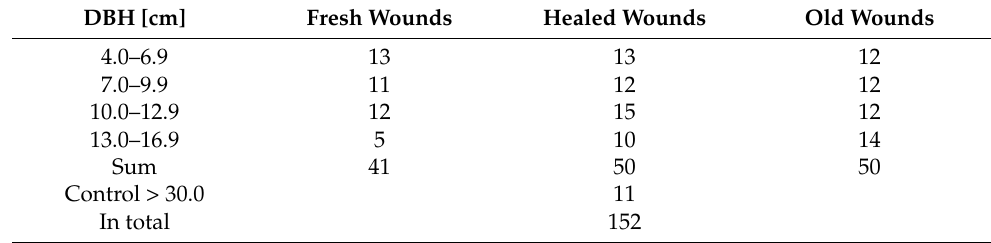
Table 1. The number of collected drill samples of sapwood in reference to the category of bark-stripping wounds of Abies alba stems.